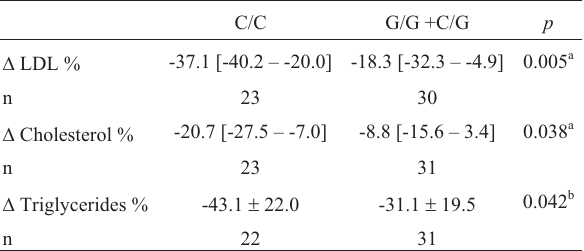
Table 4 - Percent change in circulating lipids following bariatric surgery according to ADIPOQ -11377 C > G (rs266729)